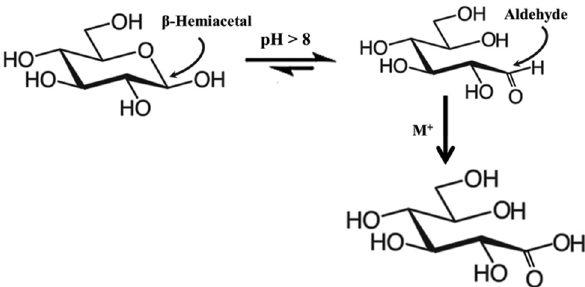
Figure 5: The adverse reducing reactivity of the cellulose molecule depends on the pH of aqueous solutions that leads to the tauto - meric equilibrium between open - chain aldehyde and